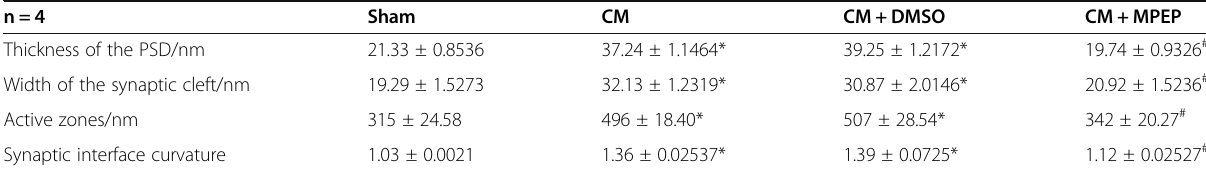
Table 3 Synaptic ultrastructure parameters in the different groups n = 4 Sham CM CM + DMSO CM + MPEP Thickness of the PSD/nm 21.33 ± 0.8536 37.24 ± 1.1464* 39.25 ± 1.2172* 19.74 ± 0.9326 # Width of the synaptic cleft/nm 19.29 ± 1.5273 32.13 ± 1.2319* 30.87 ± 2.0146* 20.92 ± 1.5236 # Active zones/nm 315 ± 24.58 496 ± 18.40* Synaptic interface